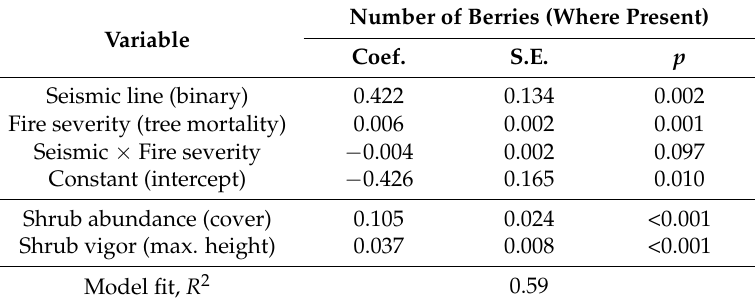
Table 3. Mixed effect linear regression results relating the berry production of Vaccinium myrtilloides to location (seismic line versus adjacent forest), fire severity, interaction of fire severity and location, abundance (cover), and